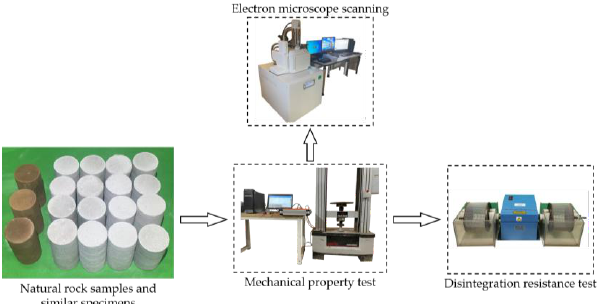
Figure 4. Test of basic physical and mechanical properties of rocks.